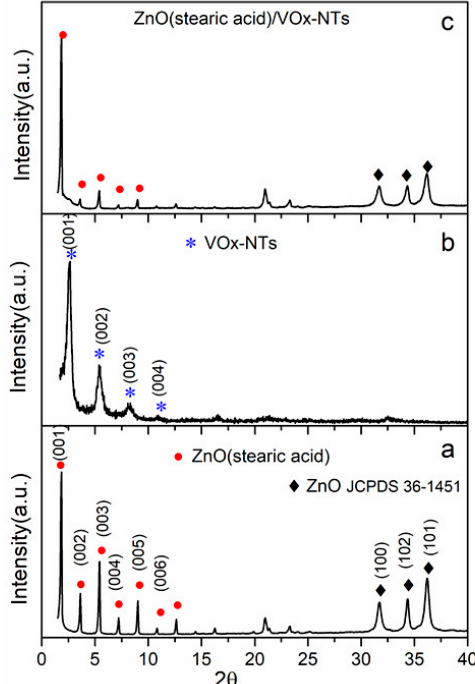
Figure 1. XRD patterns of ( a ) ZnO (stearic acid), ( b ) Vox-NTs and ( c ) nanocomposite hybrid ZnO/VOx-NTs. The peak positions in the reference diffraction pattern of ZnO are also indicated.